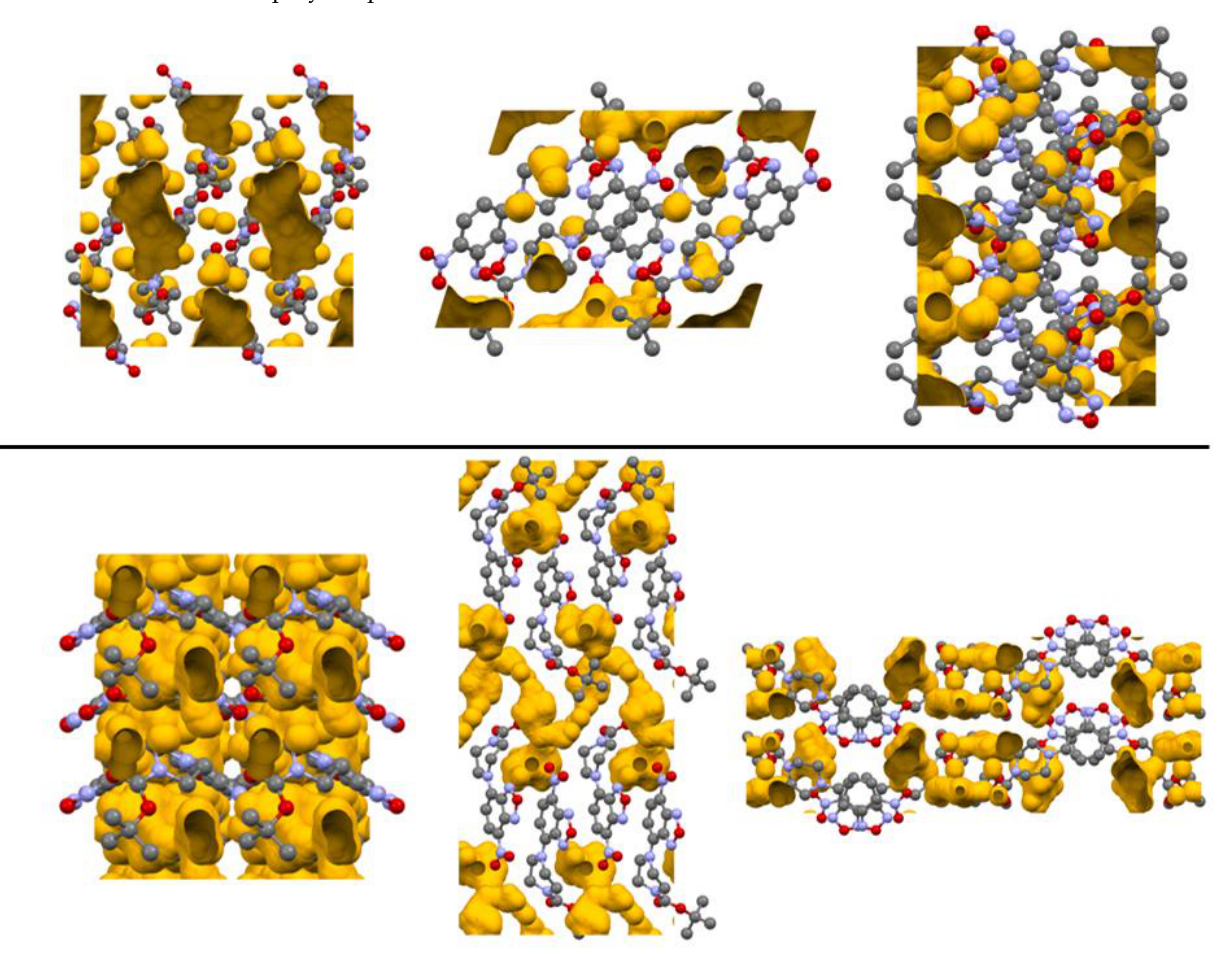
Figure 8. Depiction of the crystalline voids in 1-M ( top ) and 1-O ( bottom ). Images are views from the crystallographic a, b, c axes from left to right. Hydrogen atoms omitted for clarity.